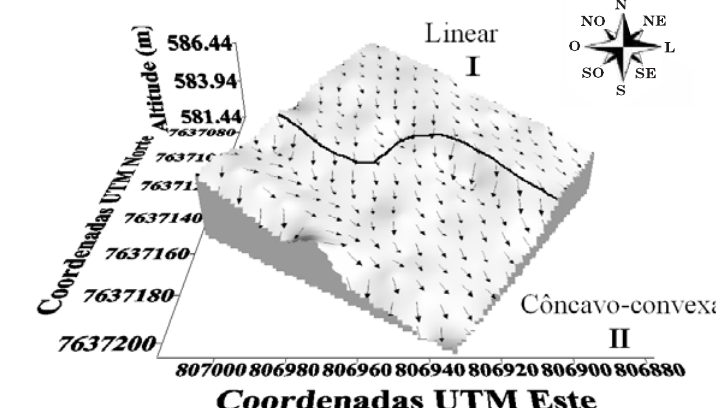
Figura 1. Modelo Digital de Elevação da área de estudo. O sentido e tamanho das setas indicam a modelagem do declive do terreno e, conseqüentemente, o fluxo de